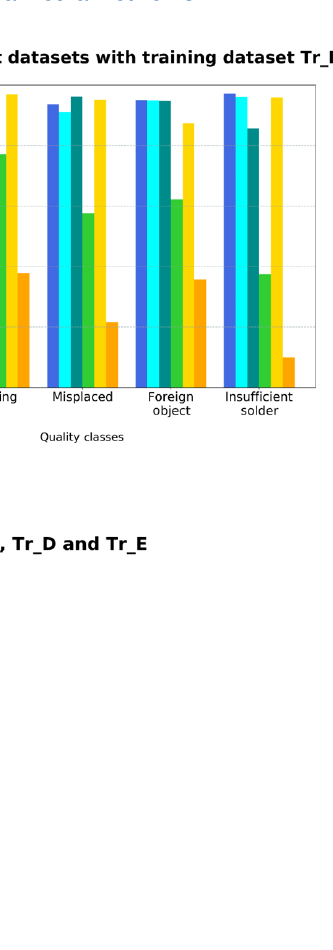
Figure 8. Detection accuracy on the resistors depending on the different training datasets.